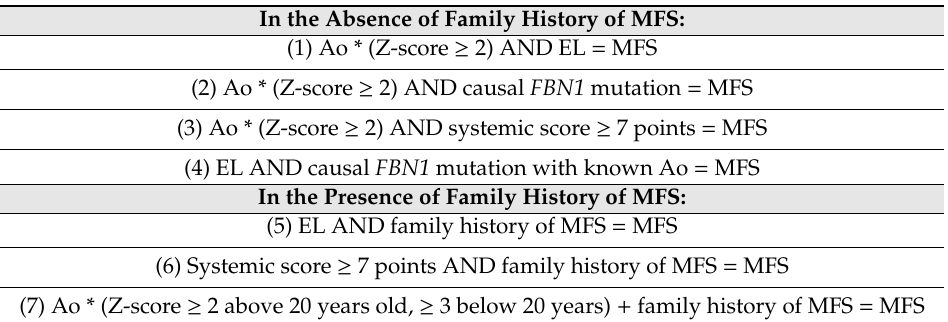
Table 1. Revised Ghent criteria for diagnosis of MFS